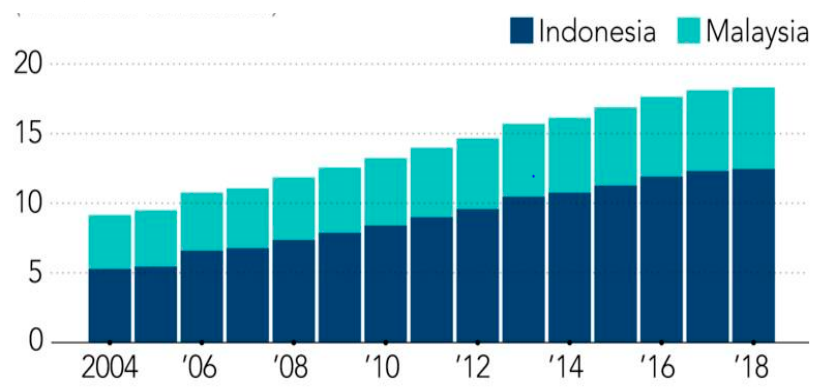
Figure 1. Palm oil production for Malaysia and Indonesia [6].